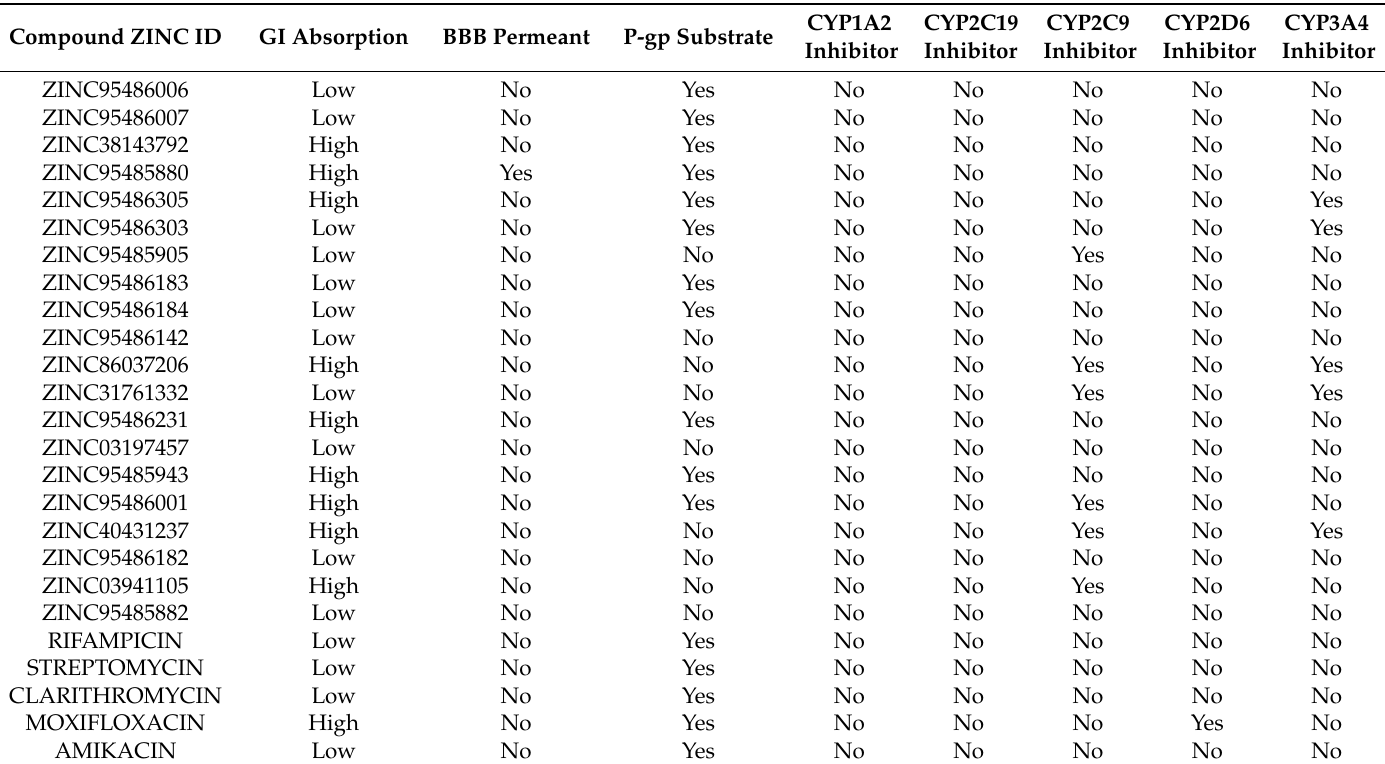
Table 4. Pharmacokinetics properties of predicted compounds and five known drugs. The pharmacokinetics properties comprised cytochrome inhibition, the blood brain barrier permeant (BBB), P-glycoprotein (P-gp) substrates, and gastrointestinal (GI)